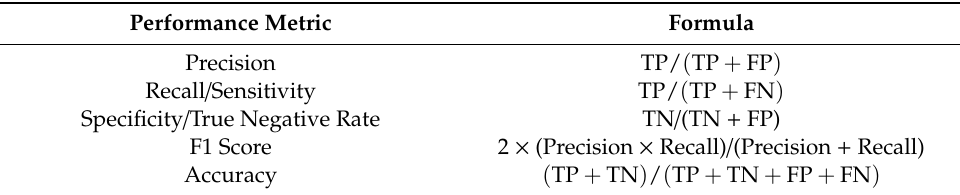
Table 3. Different outcomes of two ‐ class prediction.